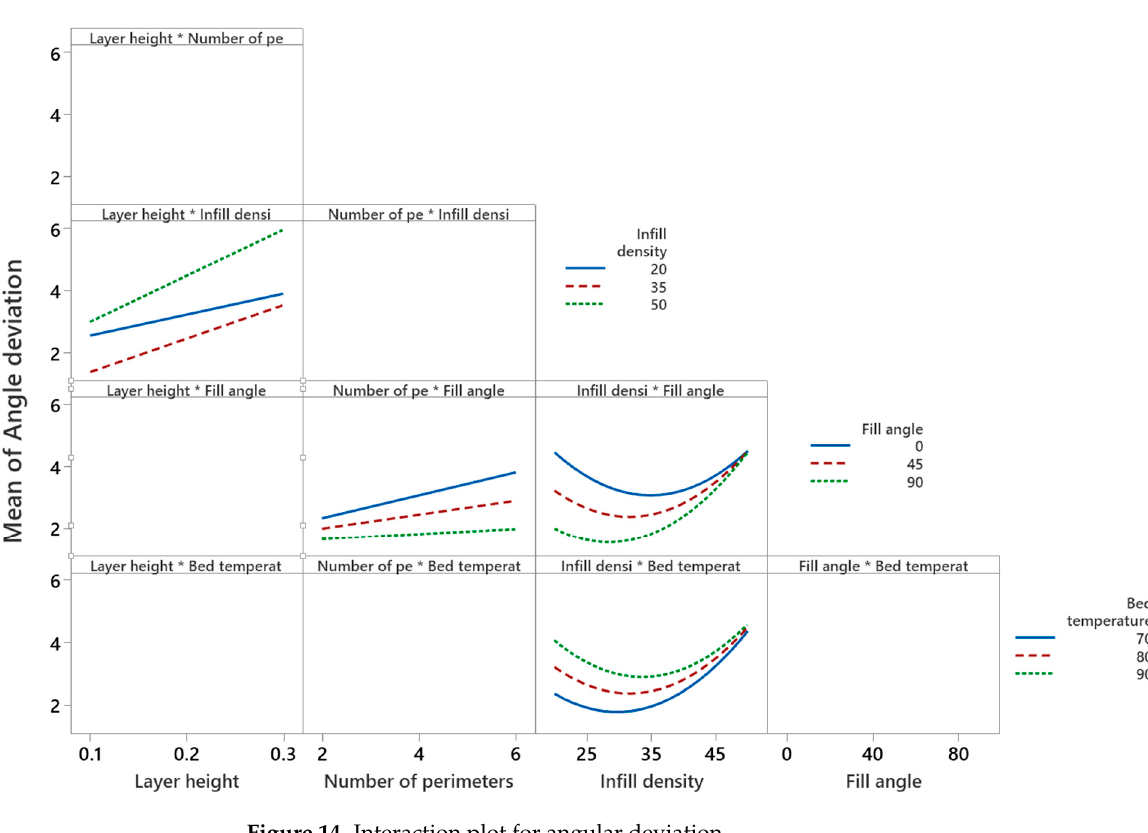
Figure 14. Interaction plot for angular deviation.